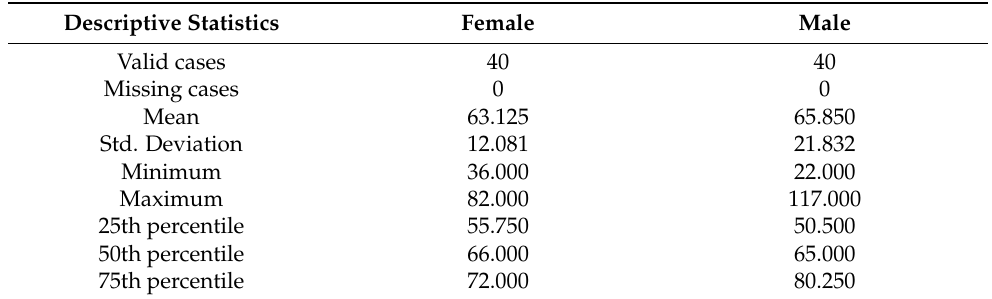
Table 1. Descriptive statistics of the rats’ head-dipping activity in the hole–board apparatus (Phase